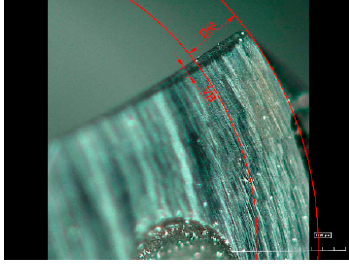
Figure 4. Magnified view of cutting lip and flank wear measurement.